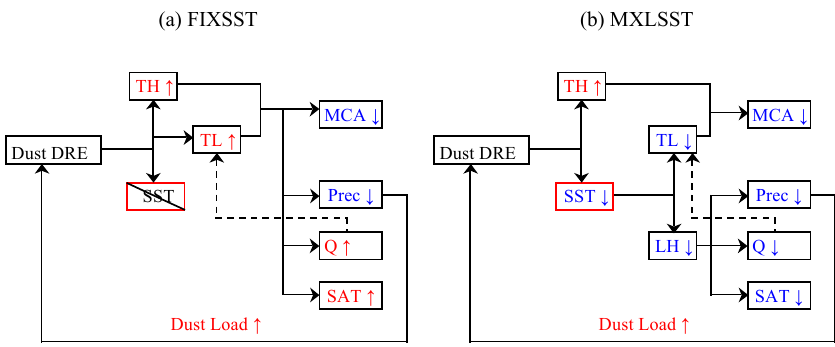
Fig. 8. Illustration of the interactions between dust and climate with (a) FIXSST and (b) MXLSST. The abbreviations stand for following variables: DRE: direct radiative effect; TH: air temperature at high troposphere; TL: air temperature at low troposphere; MCA: middle cloud amount; Prec: precipitation; Q: specific humidity; SAT: surface air temperature; LH: latent heat. The upward (or downward) arrow indicates an increase (or decrease) of a variable on a global